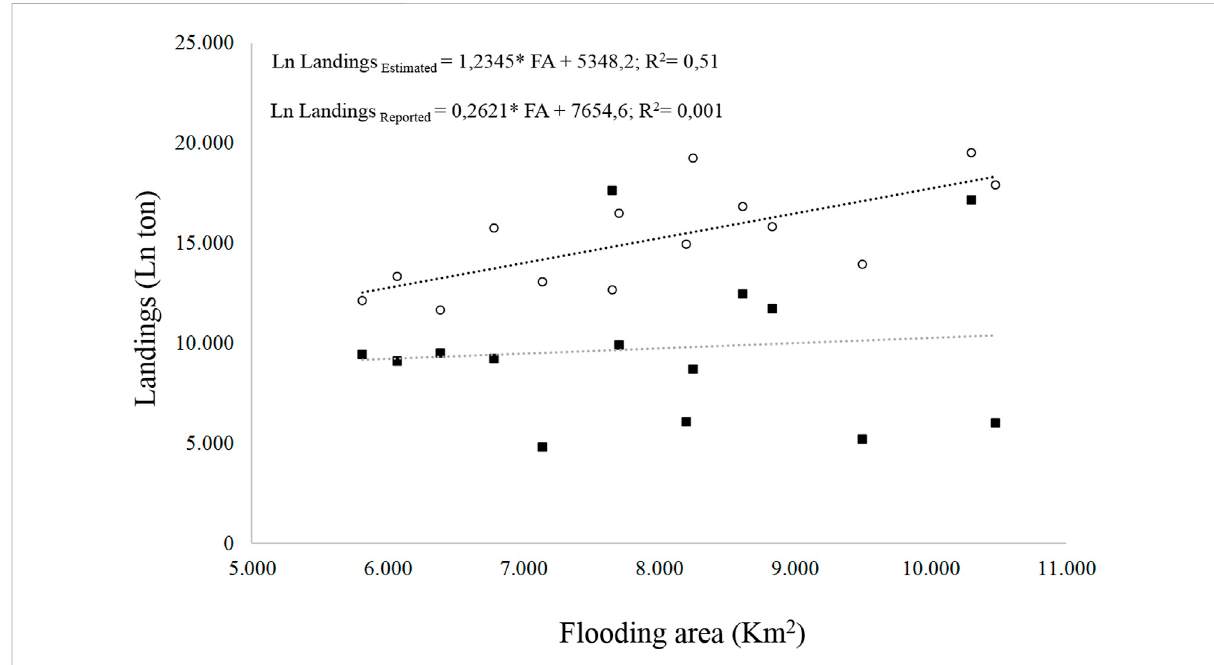
FIGURE 6 Relation between the fl ooded area and the landings of the freshwater fi sheries (estimated empty circle, reported black